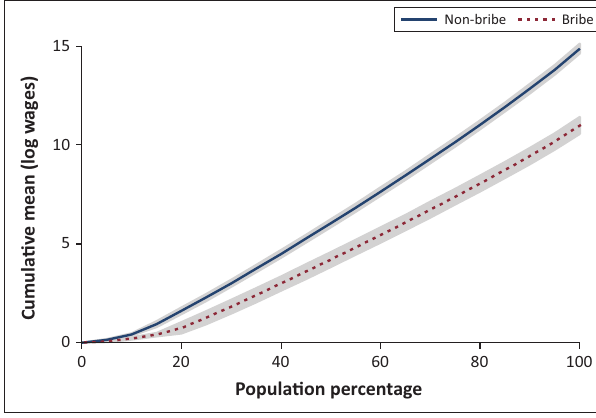
Non-bribe Bribe